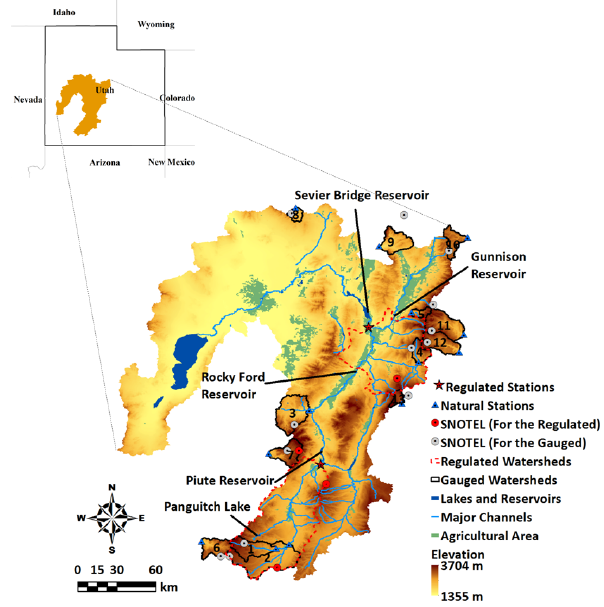
Fig. 1. Physical layout of the Sevier River basin,